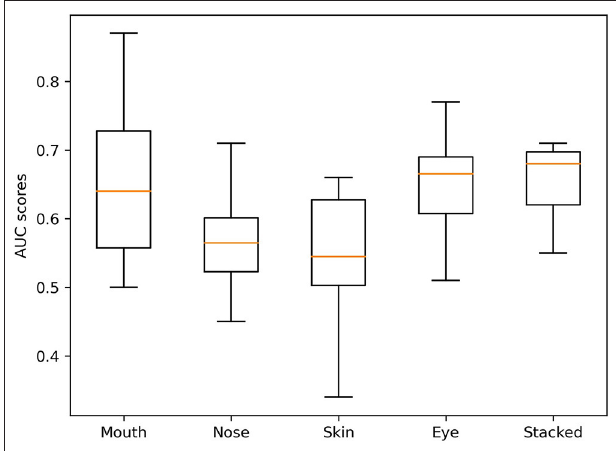
FIGURE 4 | Box-and-whiskers plot of AUC scores of the final